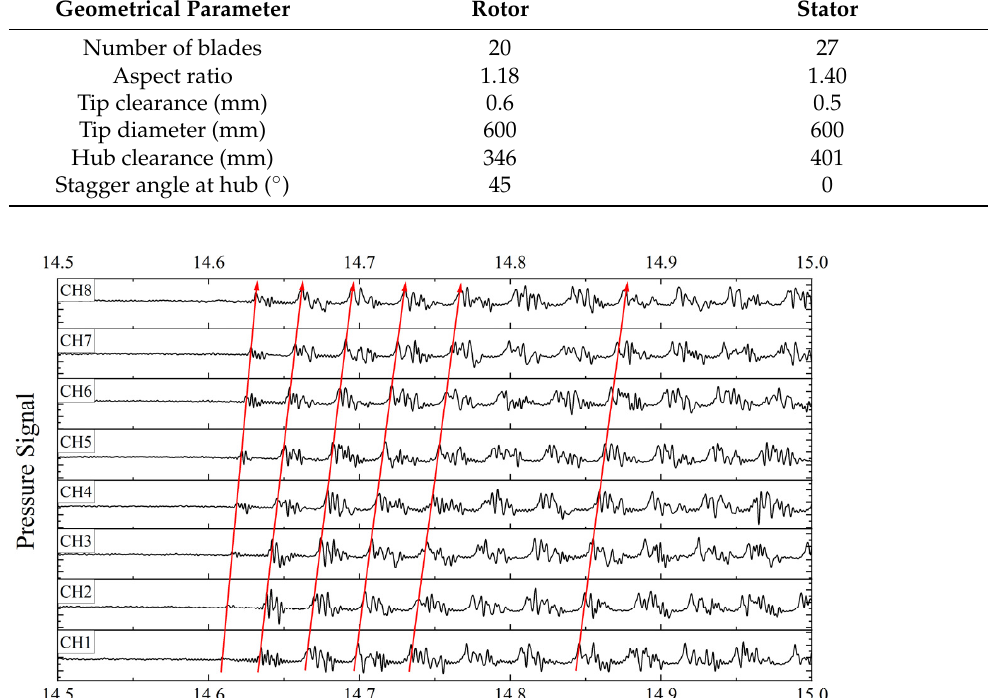
Table 2. The structural design parameters of TA36 [41].